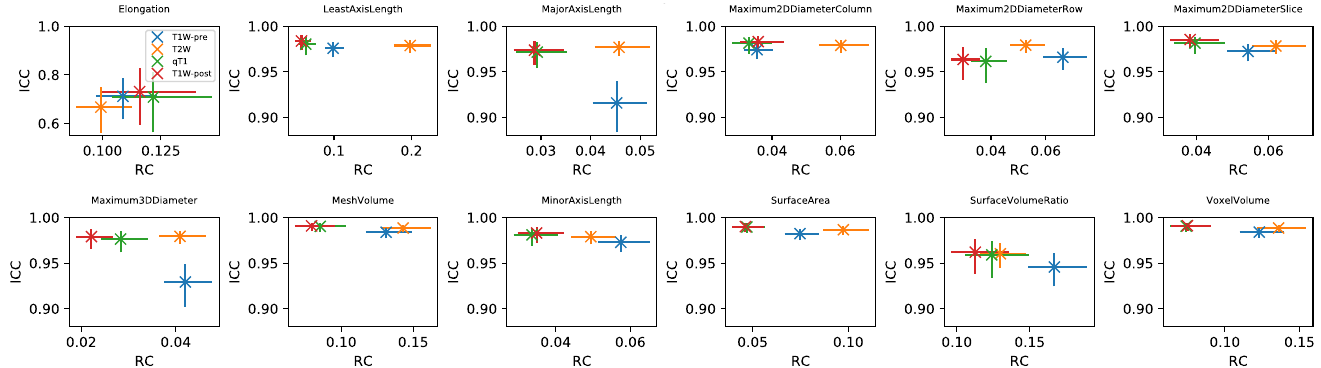
Figure 5. Plots of RC against ICC for Shape features, for four sequences (colours). In each panel, data points and error bars represent point estimates and 95%